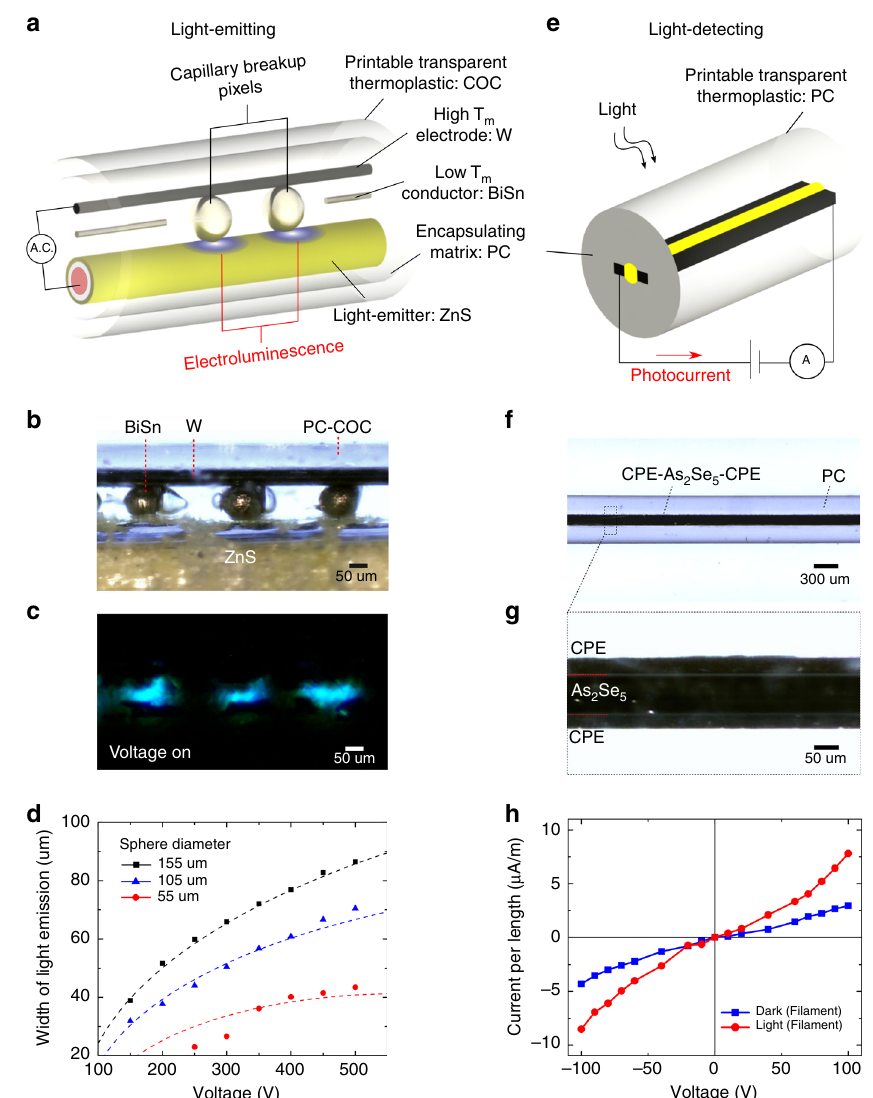
Fig. 2 Characterization of the Optoelectronic Filaments. a Schematic of the pixelated light-emitting fi lament, illustrating the fi lament design for light- emission. b Optical micrograph of the in- fi lament low melting-point (T m ) BiSn conductive spheres electrically interfacing high melting-point W and ZnS. c Electroluminescent light-emission from ZnS at distinct sphere locations in ( b ). d Plot of width of light-emission versus AC voltage for different sphere sizes. The plotted dotted lines are derived from the theoretical framework presented in Supplementary Note 1. e Schematic of the light-detecting fi lament, with an external circuit connected to opposite ends of the different electrodes. f , g Planar optical micrographs of long-distance intimate electrical contact between CPE and As 2 Se 5 , which contributes to h generation of photocurrent upon light impingement. Both fi laments are cladded by a printable thermoplastic (COC or PC) and contain functional interfaces between disparate materials classes immobilized by a PC limited by the nozzle dimensions and wetting. We later show in Fig. 3e, f, the ideal process parameters, namely the print speed and nozzle temperature, required to achieve both good polymeric adhesion and retainment of device functionality for the light- detecting and light-emitting fi laments. Comparing the parameter map between both fi laments, we note that the inclusion of a lower T g outer adhesion cladding around a higher T g core expands the speed-temperature area in which one achieves the desired strong adhesion with preservation of functionality. This strategy of ele- vating the glass transition temperature from the outer fi lament cladding to the inner core material reduces the failure of fi lament device printing, and can thus be implemented for future printing of multimaterial fi laments with functionalities other than optoe- lectronics as described in the work.